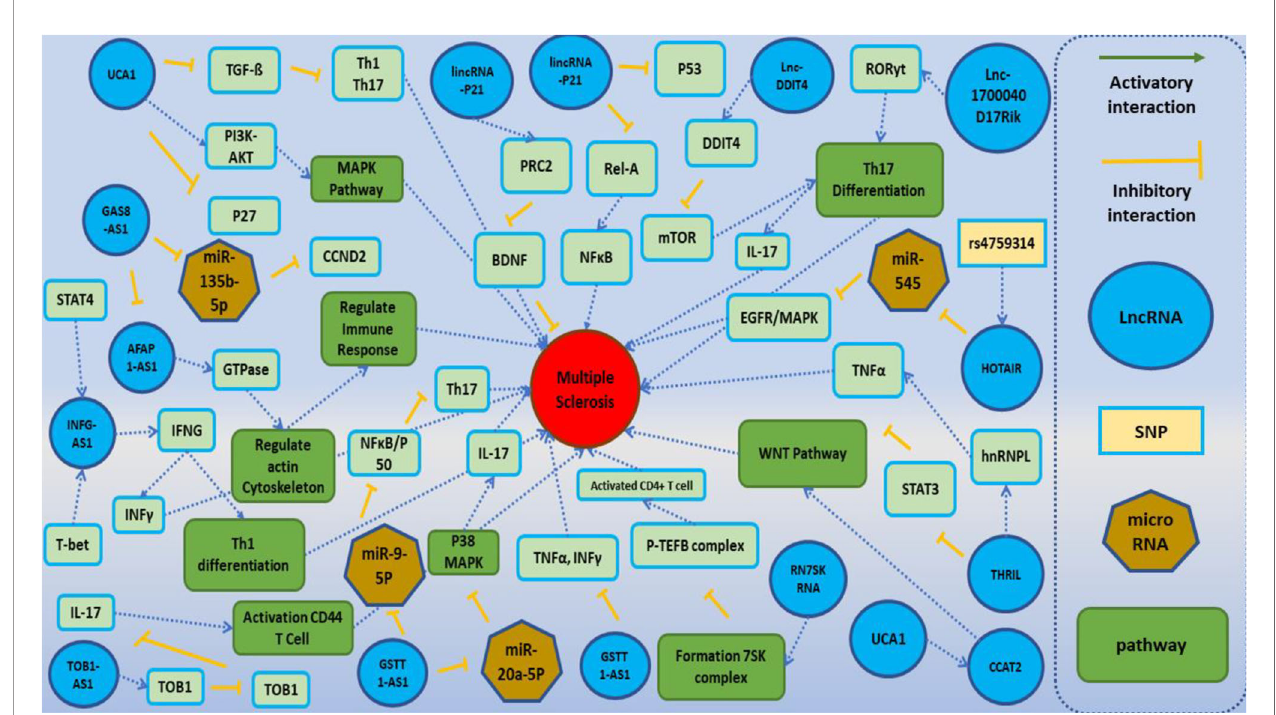
FIGURE 2 | A schematic diagram of the role of several lncRNAs involved in the modulation of the main molecular cascades in multiple sclerosis (MS). One of the main pathophysiological mechanisms associated with the MS involves T cells subsets [regulatory T cells (Treg), Th1, Th2, and Th17 cells]. Dysregulation of these subsets activates in fl ammatory cascades and cytokine secretion and ultimately leads to demyelination within the brain and spinal cord and neuronal damage. Lnc-DC has been shown to be upregulated in PBMCs of MS patients. Upregulation of this lncRNA activates Toll-like receptor 4 (TLR4) and TLR9. TLR4 has a central role in the secretion of in fl ammatory cytokines such as IL-1, IL-6, and IL-17 and suppresses Treg cells. Also, TLR4 increases the differentiation of Th17 through inhibition of miR-30a (24, 65). Moreover, lnc-DDIT4 is upregulated in the PBMCs of MS patients. This lncRNA binds to DDIT4 and regulates immune response and differentiation of Th17 (69). BDNF-AS has a role in the recruitment of PRC2 and inhibition of the neuroprotective factor BDNF (41). GSTT1-AS1 inhibits the progression of MS through inhibition of secretion of IFN- g and TNF- a (36). TUG1 activates p38 MAPK signaling pathway through suppression of miR- 20a-5p, so downregulation of TUG1 decreases Th17 differentiation. UCA1 has a role in the regulation of activity of PI3K – AKT, ERK1/2, and MAPK cascades and Th17 differentiation. Also, this lncRNA has interaction with another lncRNA, namely, CCAT2. CCAT2 induces WNT cascade signaling and enhances the production of in fl ammatory cytokines (28,